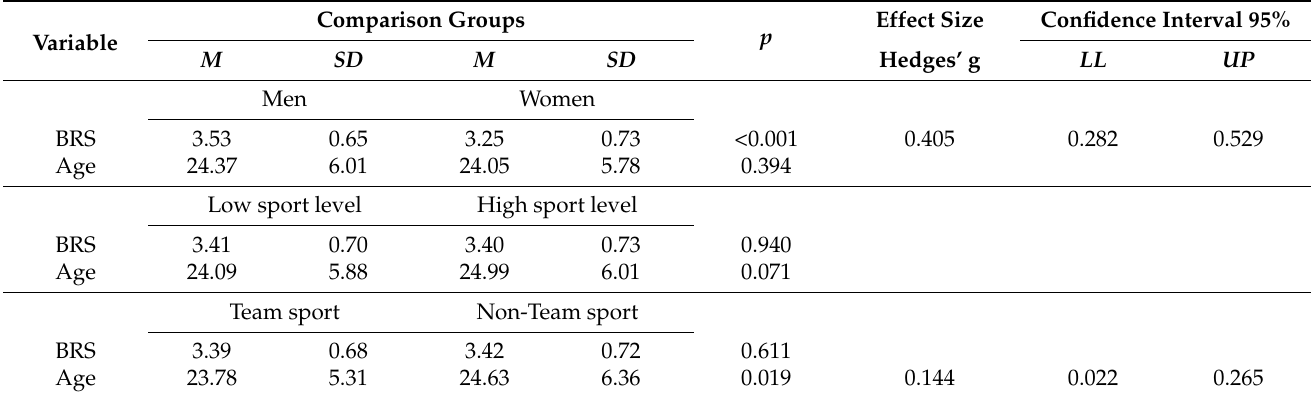
Table 2. Age and resilience comparisons by groups of gender, sport level, and sport type.